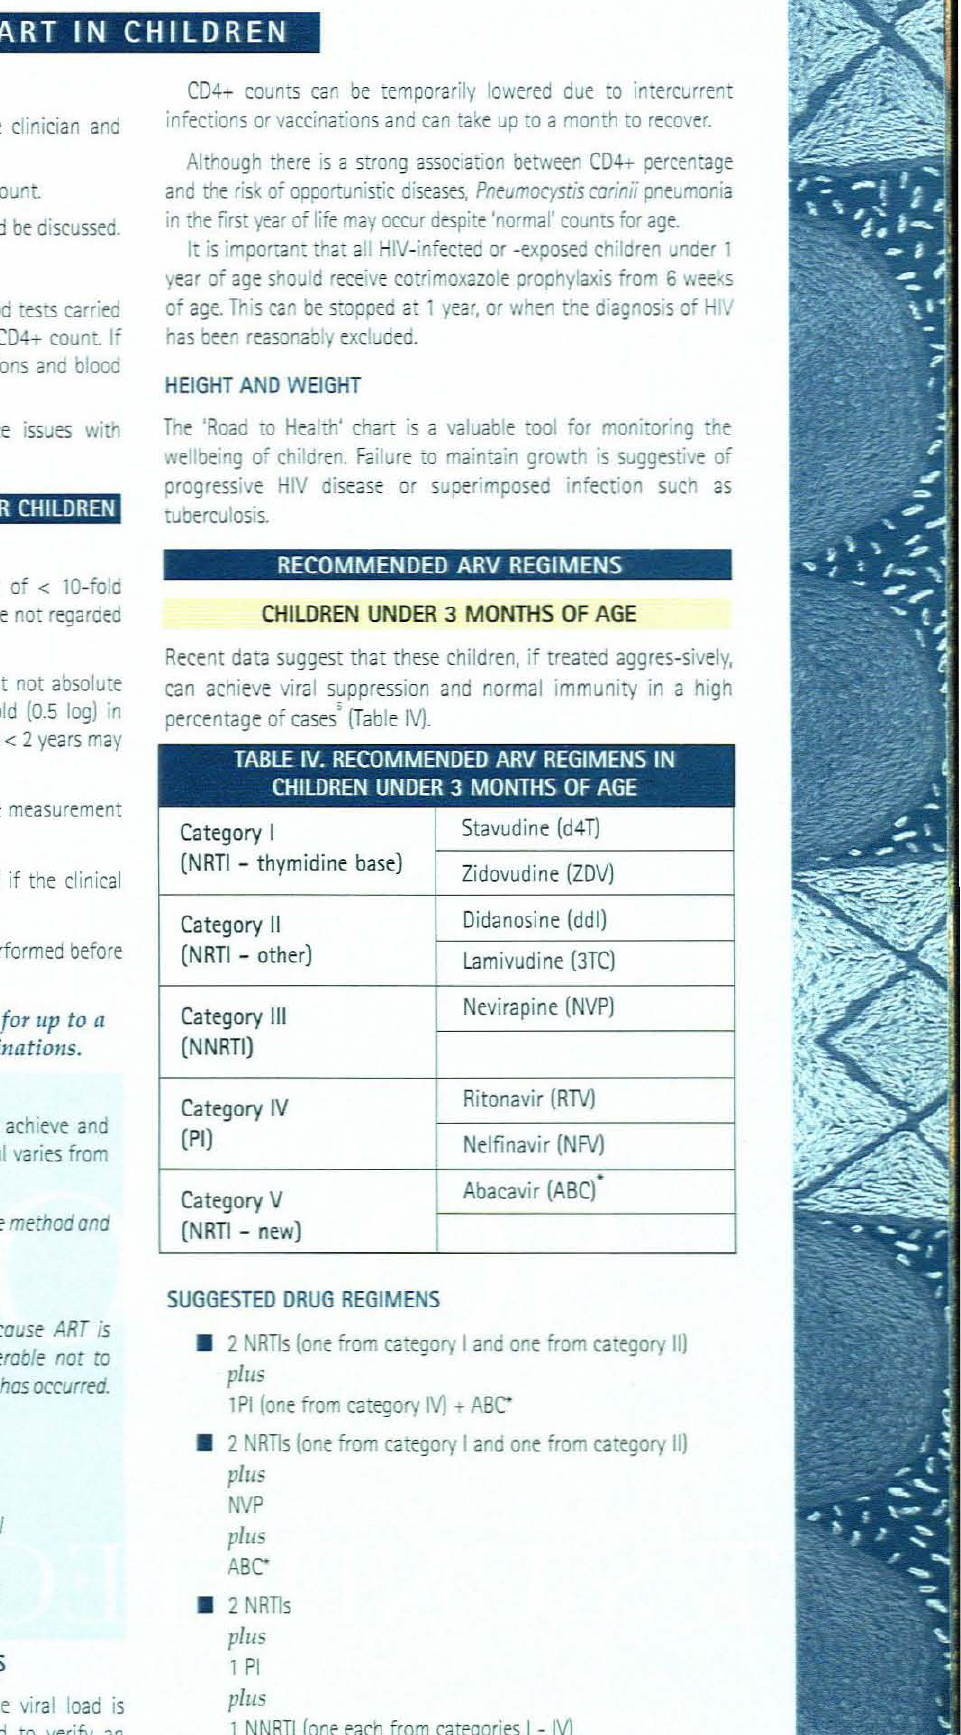
TABLE IV. RECOMMENDED ARV REGIMENS